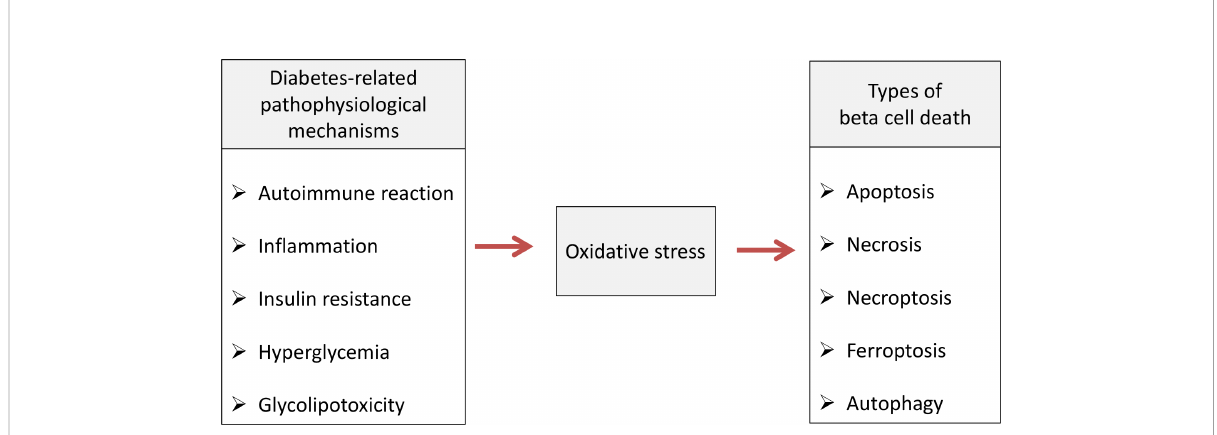
FIGURE 1 Oxidative stress-mediated pathophysiological mechanisms cause various types of beta cell death in diabetic condition. Pathophysiological processes such as autoimmune reaction, in fl ammation, insulin resistance, hyperglycemia/glucotoxicity and lipotoxicity lead to pancreatic beta cell death in diabetic condition by inducing oxidative stress which is involved in apoptosis, necrosis, necroptosis, ferroptosis and